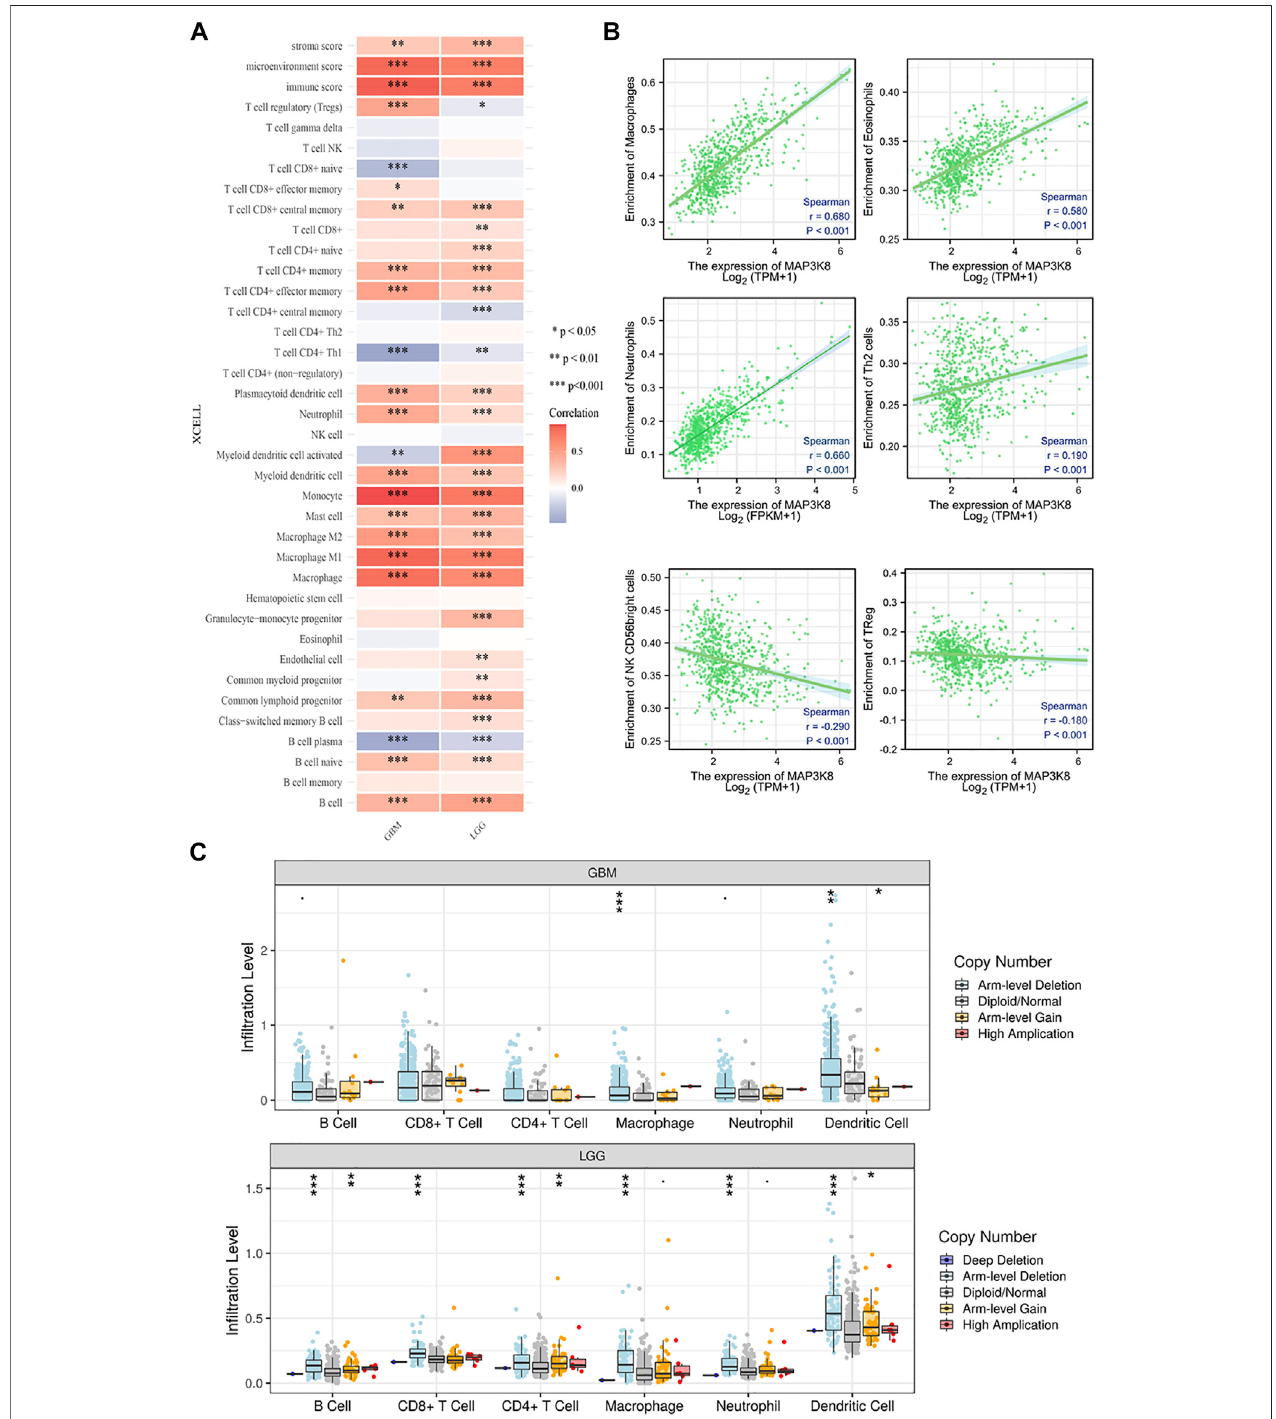
FIGURE 6 | Correlation analysis of MAP3K8 with immune in fi ltration in glioma. (A) Heatmap of the immune cell scores, where different colors represent the correlation between the immune cell scores and MAP3K8 expression. The xCell algorithms were utilized to make reliable immune in fi ltration estimations. (B) Analysis of therelationshipbetweenMAP3K8expression andimmunein fi ltrationinglioma. Theimmunecellin fi ltrationlevelwasquanti fi edbyssGSEAalgorithms. (C) Somaticcopy number alteration (SCNA) module showing the comparison of the tumor in fi ltration levels among tumors with different somatic copy number alterations for MAP3K8. SCNAs were de fi ned using GISTIC